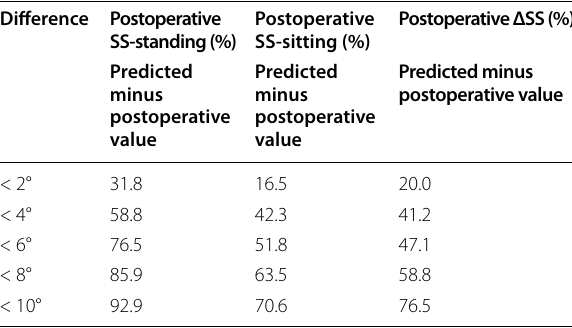
Table 4 Values of predicted and postoperative parameters and comparative analysis